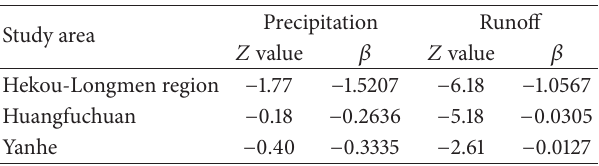
Table 2: Trend of precipitation and runoff in the Hekou-Longmen region, Huangfuchuan, and Yanhe.